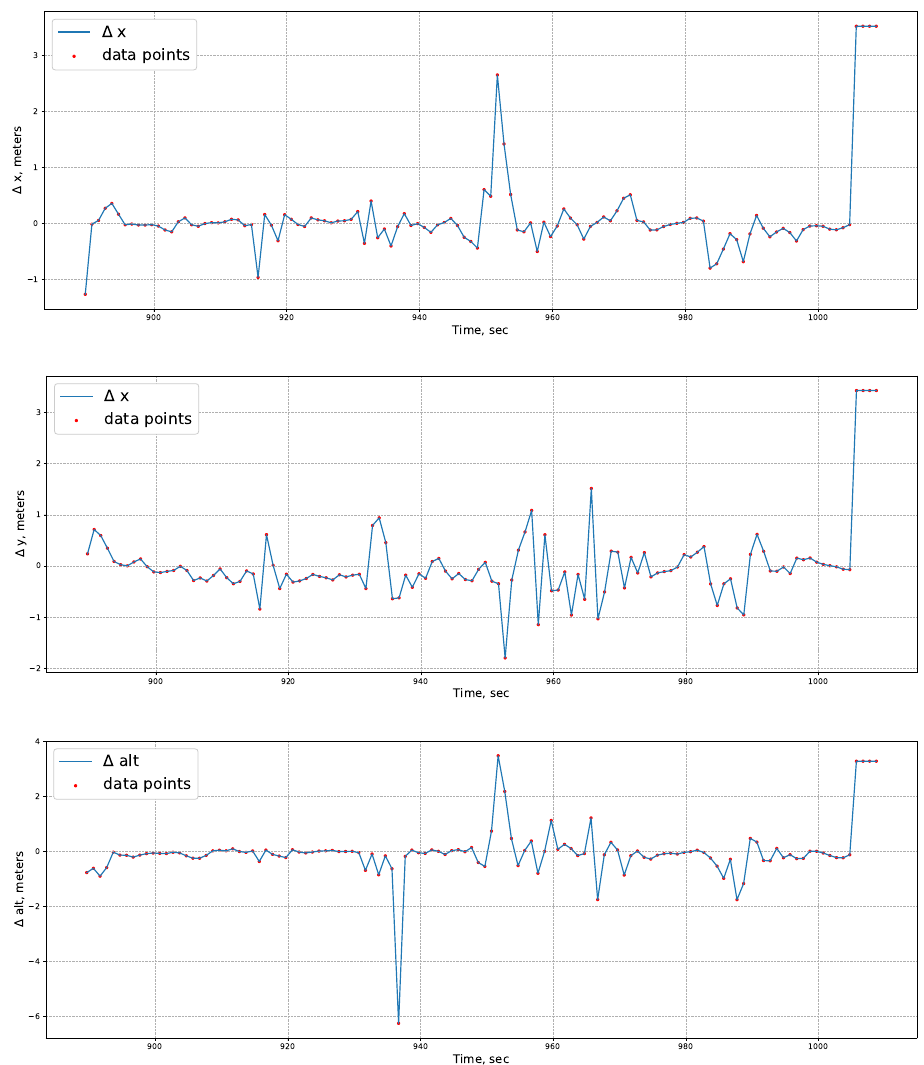
Figure 2. Model errors when forecasting by coordinates x , y , alt in the universal Mercator projection. Here ∆ x , ∆ y and ∆ alt are displacements at k step relative to k − 1 step in longitudinal range, lateral range and altitude,